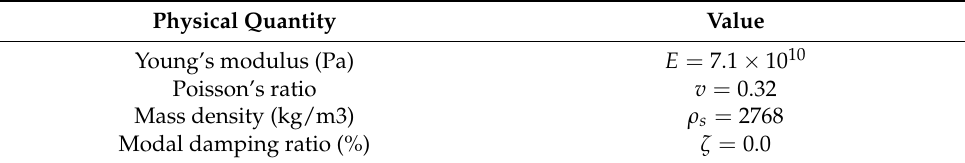
Table 1. Physical parameters of the square panel.